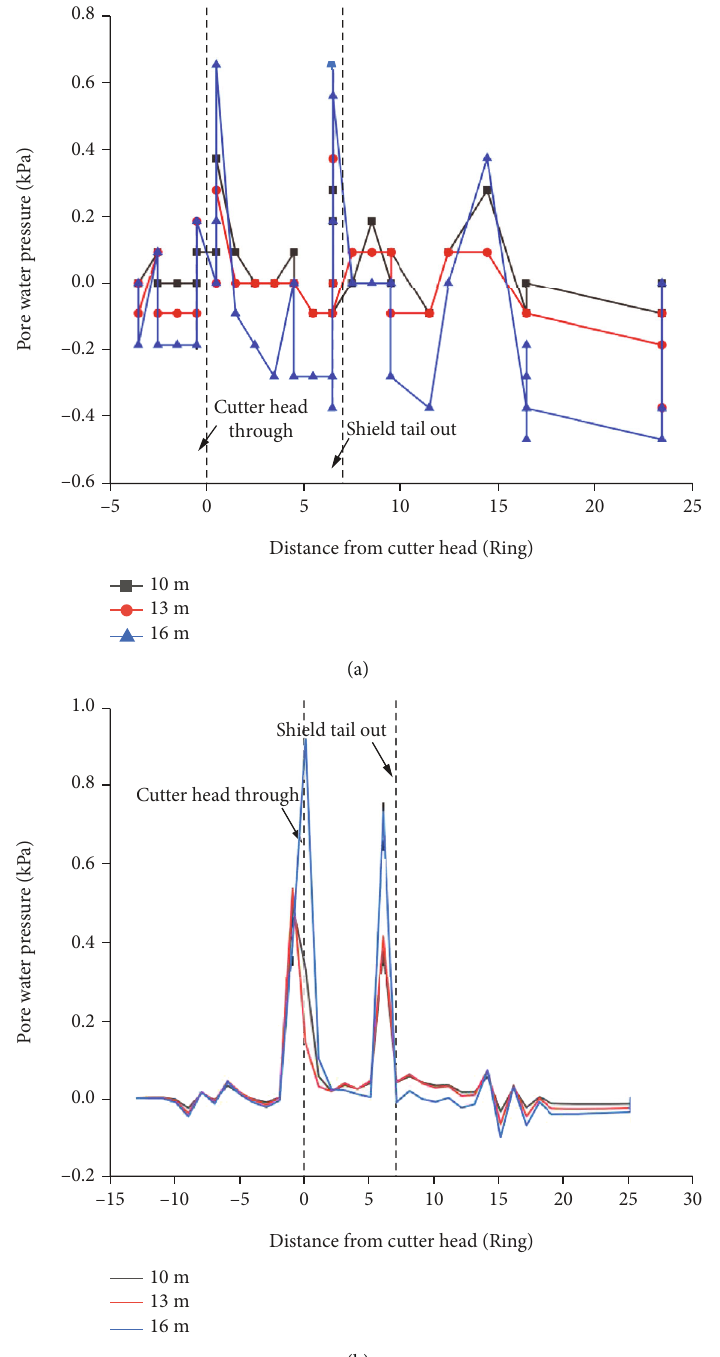
Figure 11: Excess pore water pressure time history curve at di ff erent buried depths of longitudinal lines on both sides of the tunnel: (a) measured values and (b) calculation